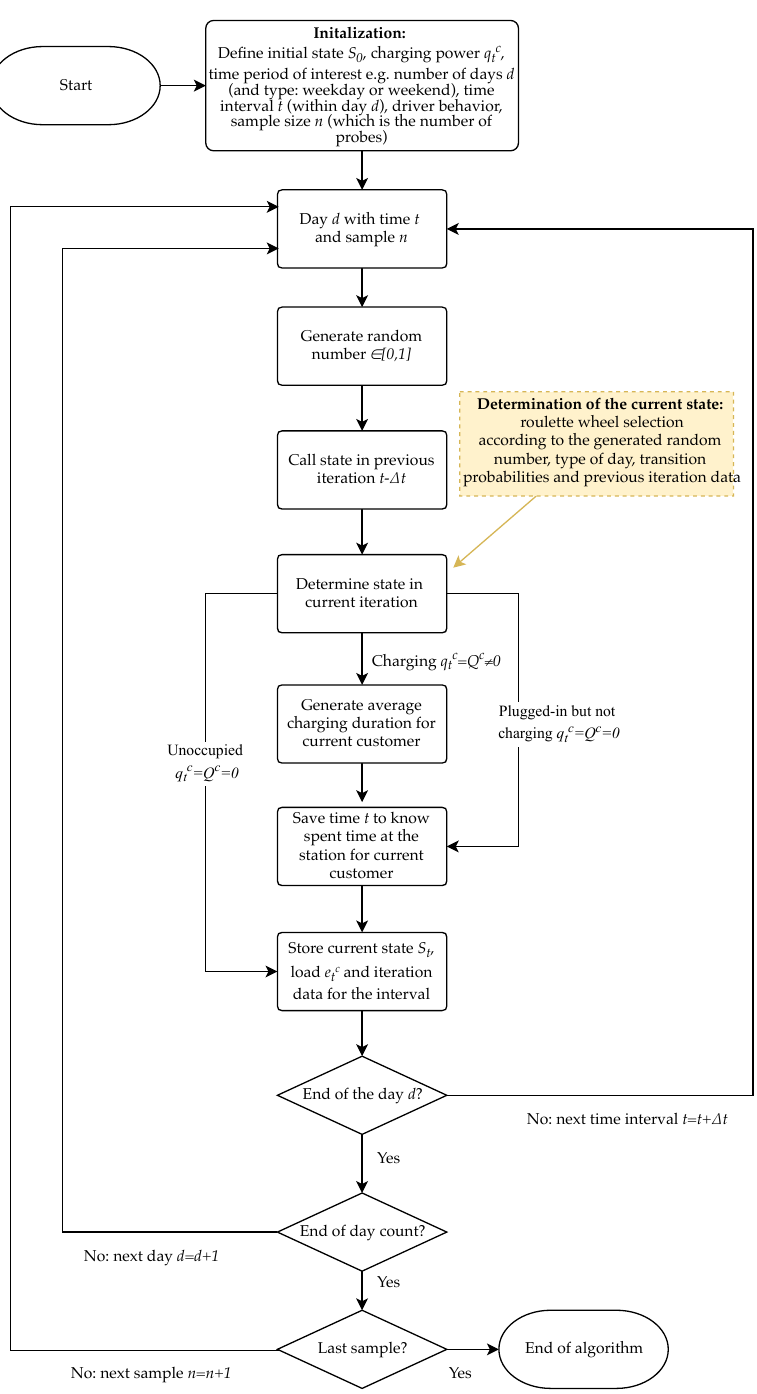
Figure 2. Algorithm